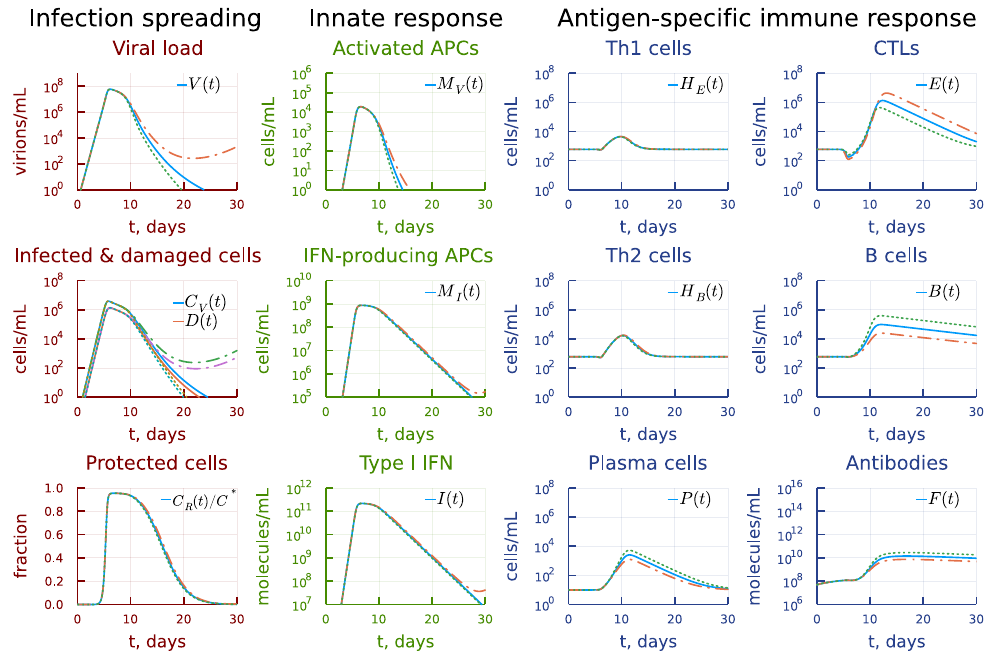
Figure 12. Effect of the rate constant of the CTL clonal activation. Dashdot: 2-fold increase of b E p with 2-fold decrease of b B p , dot: 2-fold decrease of b E p with 2-fold increase of b B p relative to baseline value.